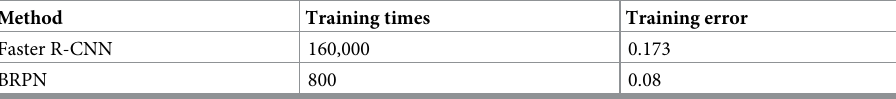
Table 9. Experiment results of the training error.